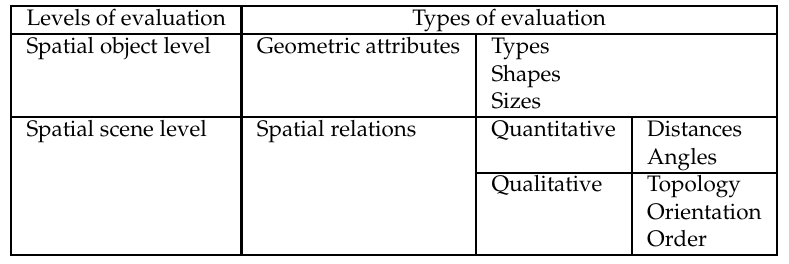
Table 1: Levels and types of